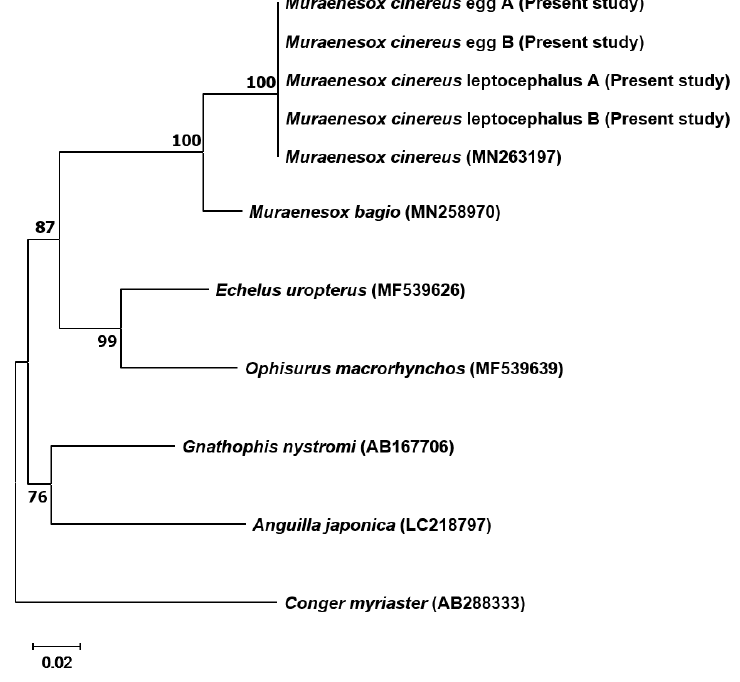
Figure 2. Neighbor-joining tree based on mtDNA 16S rRNA sequences, showing the relationships between two M. cinereus eggs and two preleptocephali from this study and six Anguilliformes species. The neighbor-joining tree was constructed using the Kimura 2-parameter distance model, with 1000 bootstrap replications. The scale bar indicates a genetic distance of 0.02. The M. cinereus eggs analyzed in this study were colorless, transparent, spherical, and segregated paternal eggs with a diameter of 2.0 – 2.2 mm (Figure 3, Table 1). The collected M. cinereus eggs were in an early stage of embryogenesis before the pigmentation of vesicles on the eyeball. The size of the perivitelline space was narrow for the species, yolk was yellow and the embryo was elongated around the yolk in a round shape (Figure 3).